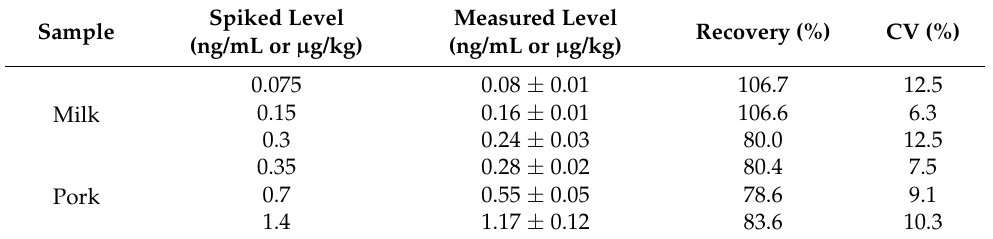
Table 1. Recovery of the TRFM-ICG for the determination of DEX in milk and pork samples ( n = 3).